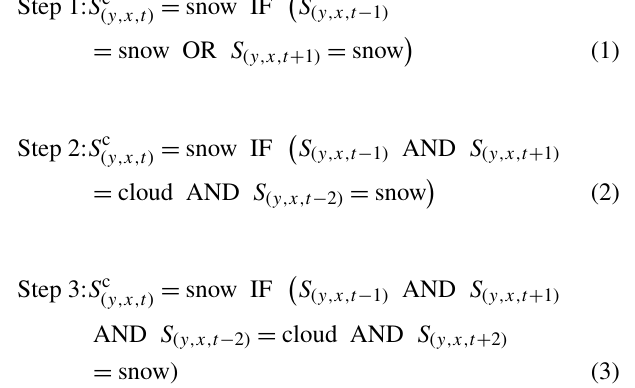
Figure 2. Methodology